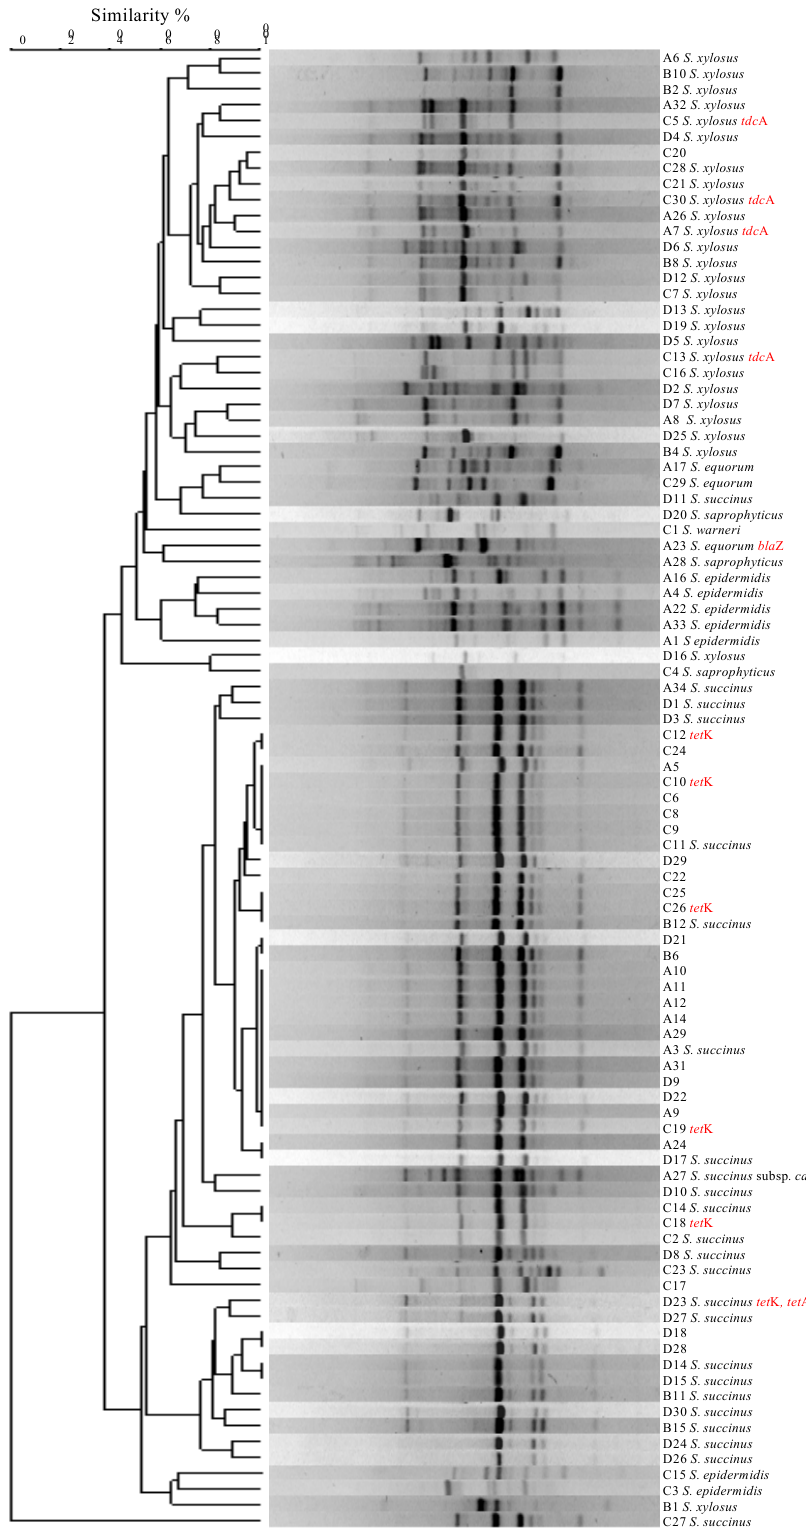
Figure 2. Clustered Rep-PCR profiles of CNS isolated from Ventricina del Vastese sausage. Iden- tification based on 16S rRNA gene is shown for isolates representing clusters separated above 90%